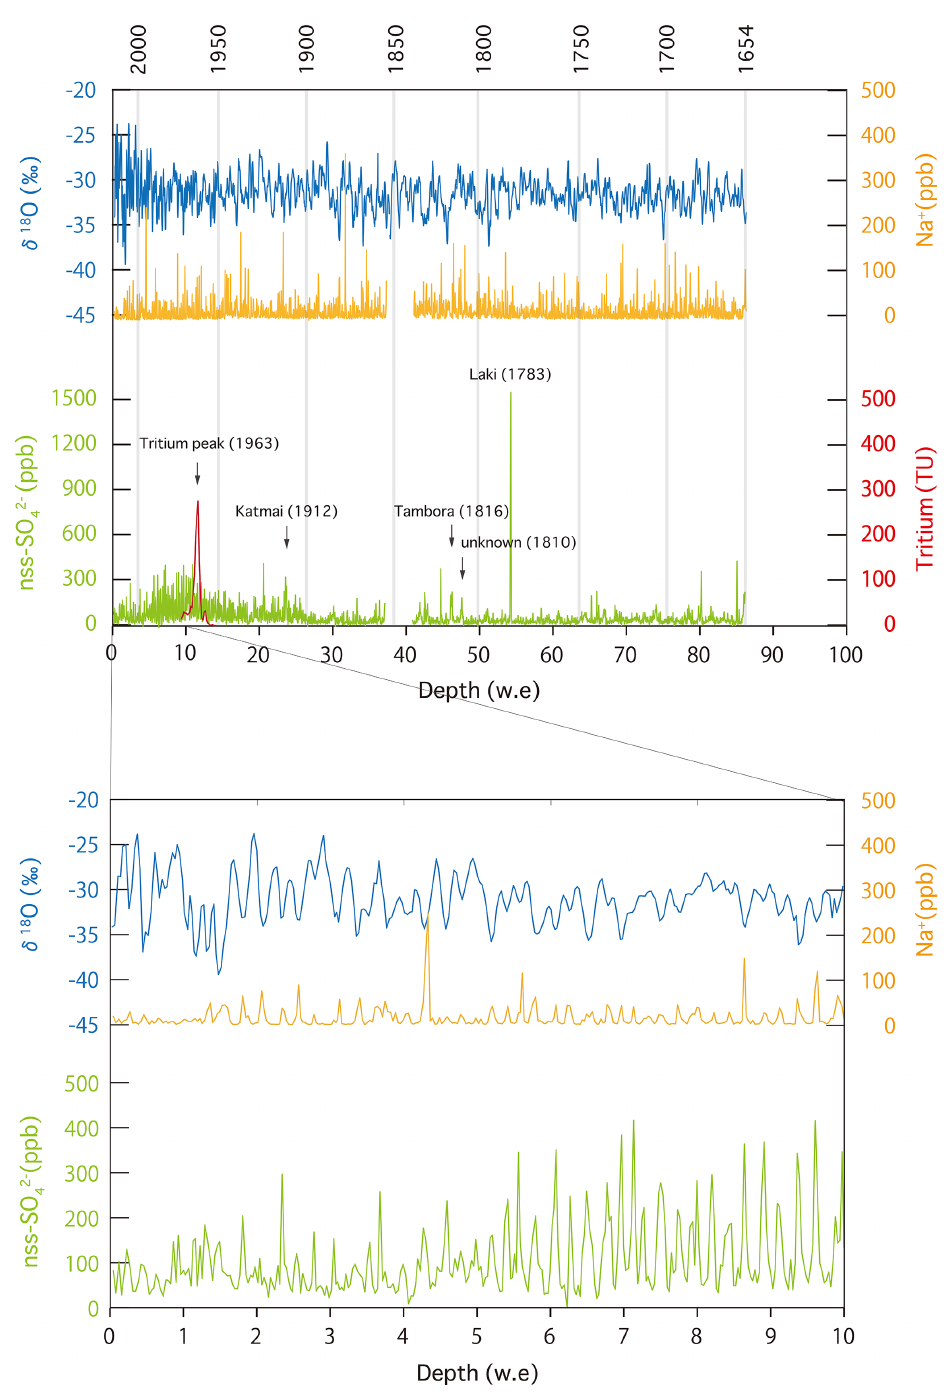
− , and tritium records in the upper 112.87m (86.06mw.e.) of the SIGMA-D ice core. Major volcanic signals Figure A1. δ 18 O, Na + , nssSO 2 4 we identified are shown in the nssSO 2 − record. The bottom plots show the enlarged record from 0 to 10mw.e. 4